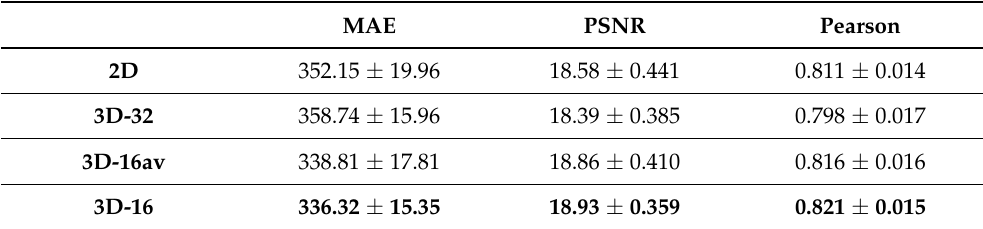
Table 5. Head dataset Bone with Atrous-Net. Mean Absolute Error, PSNR and Pearson coefficient within the bone on the head data set obtained using Atrous net with different convolutions and reconstructions.